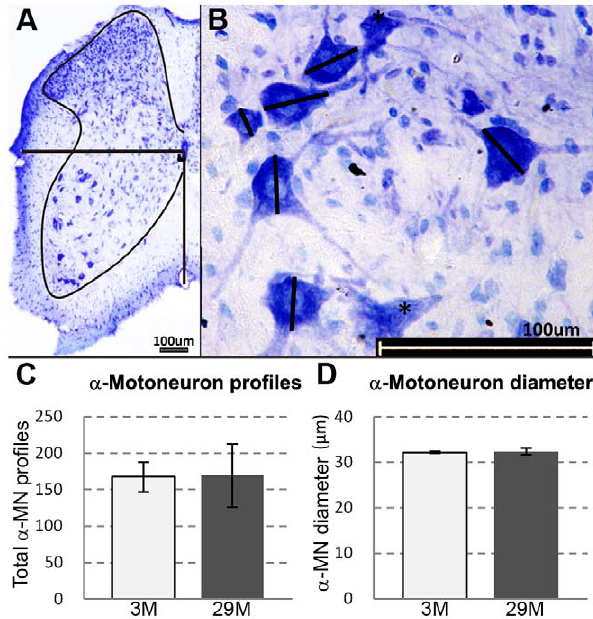
Figure 1. Lumbar spinal cord a -motoneurons. a -motoneurons stained with toluidine blue in the ventro-lateral quarter of the spinal cord between the bold lines were counted (A). The maximum diameter of a -motoneurons was obtained by measuring the longest axis through the nucleolus (B). Motoneurons with no visible nucleolus (*) or with diameters , 25 m m were not included. Total number of a -motoneuron profiles (C) and average diameter (D) of a -motoneurons were analyzed in 20 sections of a 1 in 20 series of the lumbar region (L1–L5) in spinal cords for each mouse. There was no significant change in the average number (C) and diameter (D) of a -motoneurons between mice aged 3 and 29 months. N=4 mice per age group. Values are mean 6 s.e.m.